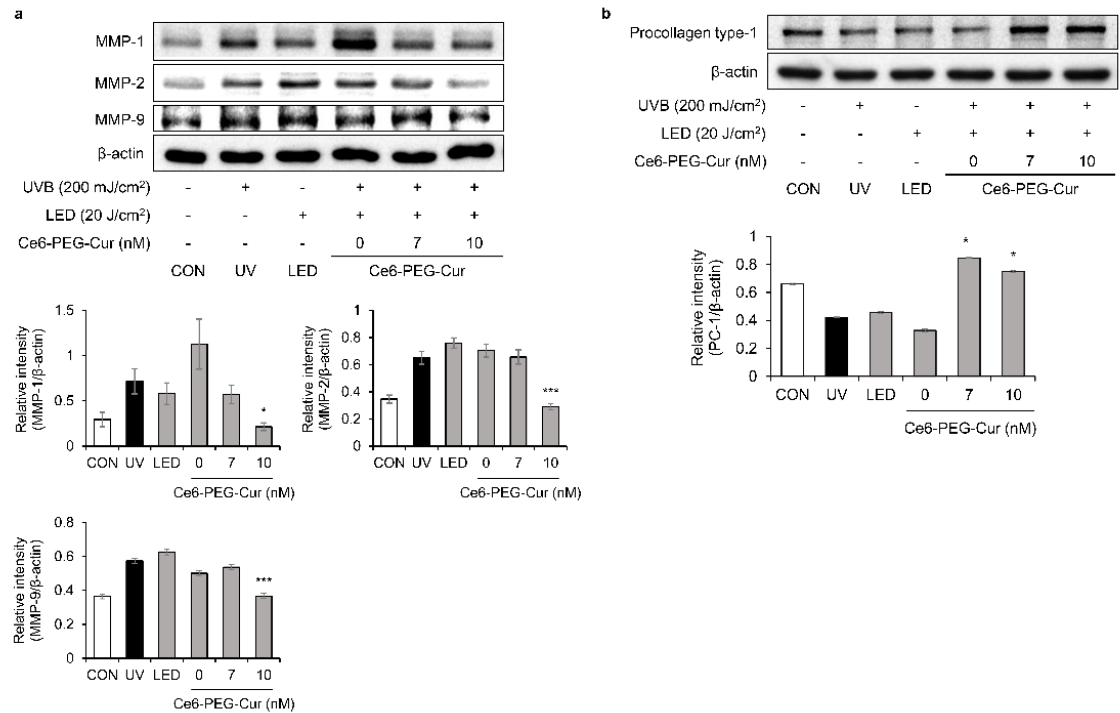
Figure 3. The effect of Ce6-PEG-curcumin-mediated PDT on MMPs and procollagen type I in UVB-irradiated Hs68 cells. The effect of Ce6-PEG-curcumin-mediated PDT on ( a ) the expression of MMP-1, MMP-2, and MMP-9 protein and ( b ) the expression of procollagen type I in UVB-irradiated Hs68 cells. Results are expressed as mean ± SD. * p < 0.05 and *** p < 0.001 vs. UVB-irradiated control.